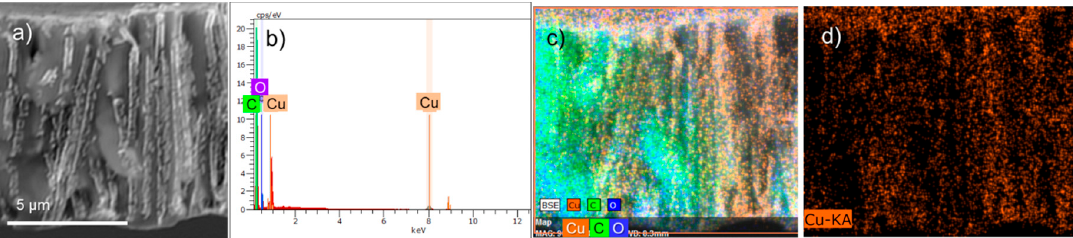
Figure 6. Cross-sectional SEM image ( a ); EDX spectrum ( b ); and combined EDX mappings of Cu, C, and O elements ( c ) for pristine composite membrane. Individual SEM-EDX mapping of copper element across the image ( d ).